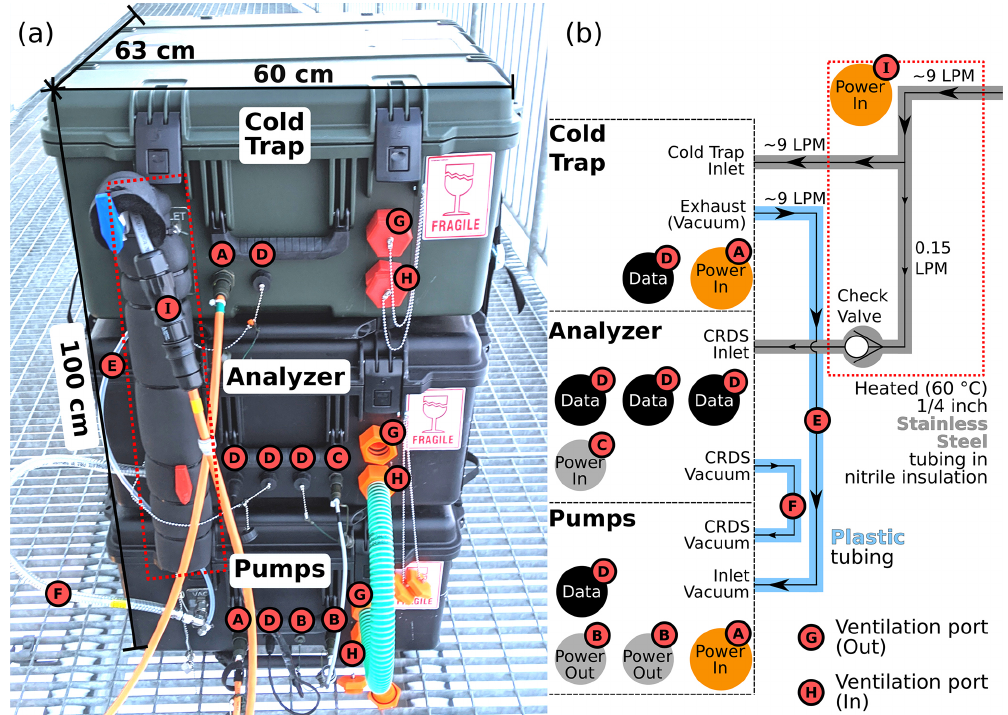
Figure 1. Overview of the ISE-CUBE system. (a) ISE-CUBEs in stacked configuration (from top to bottom): cold-trap expansion module, analyzer module, and pump module. (b) Flow diagram for the entire ISE-CUBE system, including flow rates and connectors. A heated inlet assembly (dotted red area in both) connects the three modules for common gas transmission. See text for